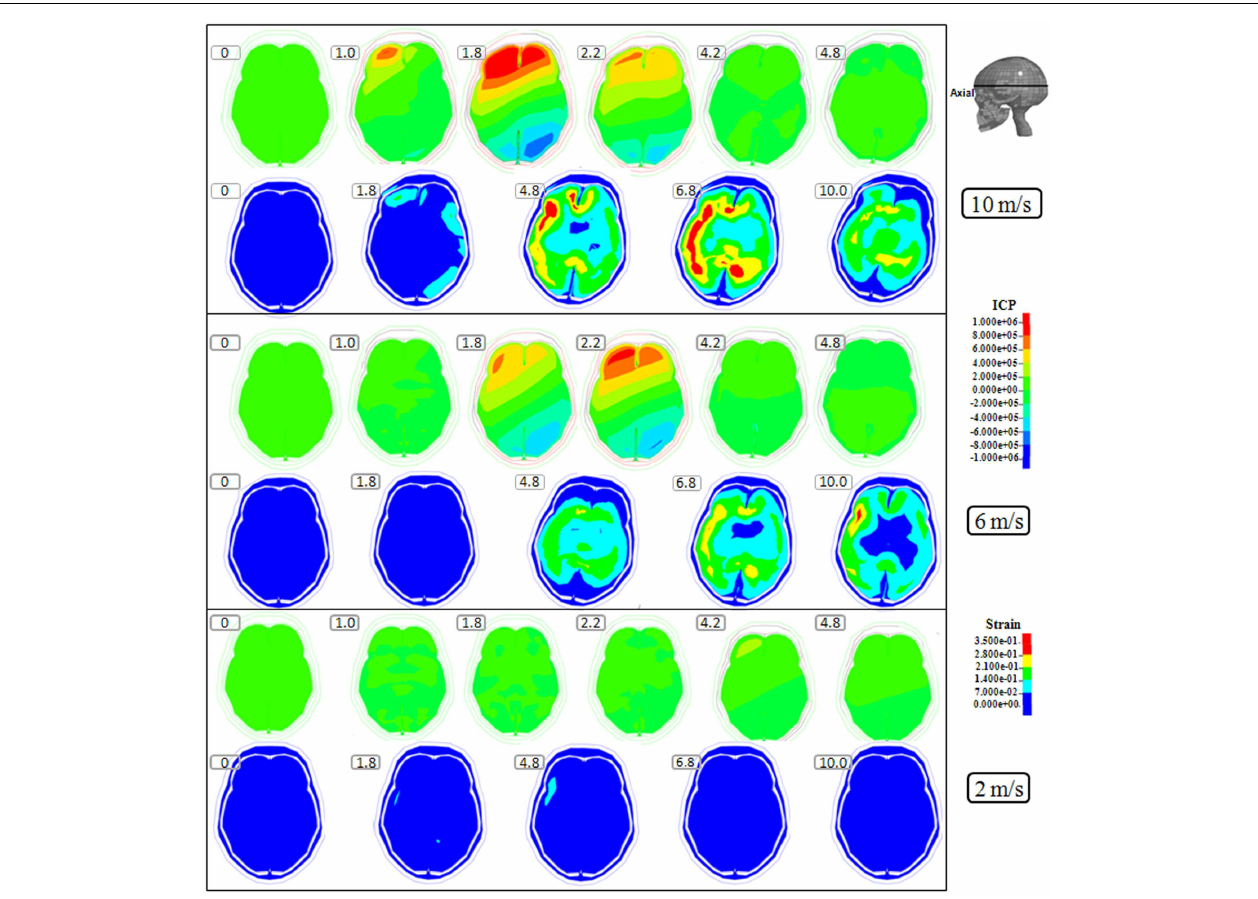
FIGURE 2 | Representative axial slice of ICP and first principal strain captured at different time points during the impact for velocities of 10m/s (two upper rows), 6m/s (two middle rows), and 2m/s (two lower